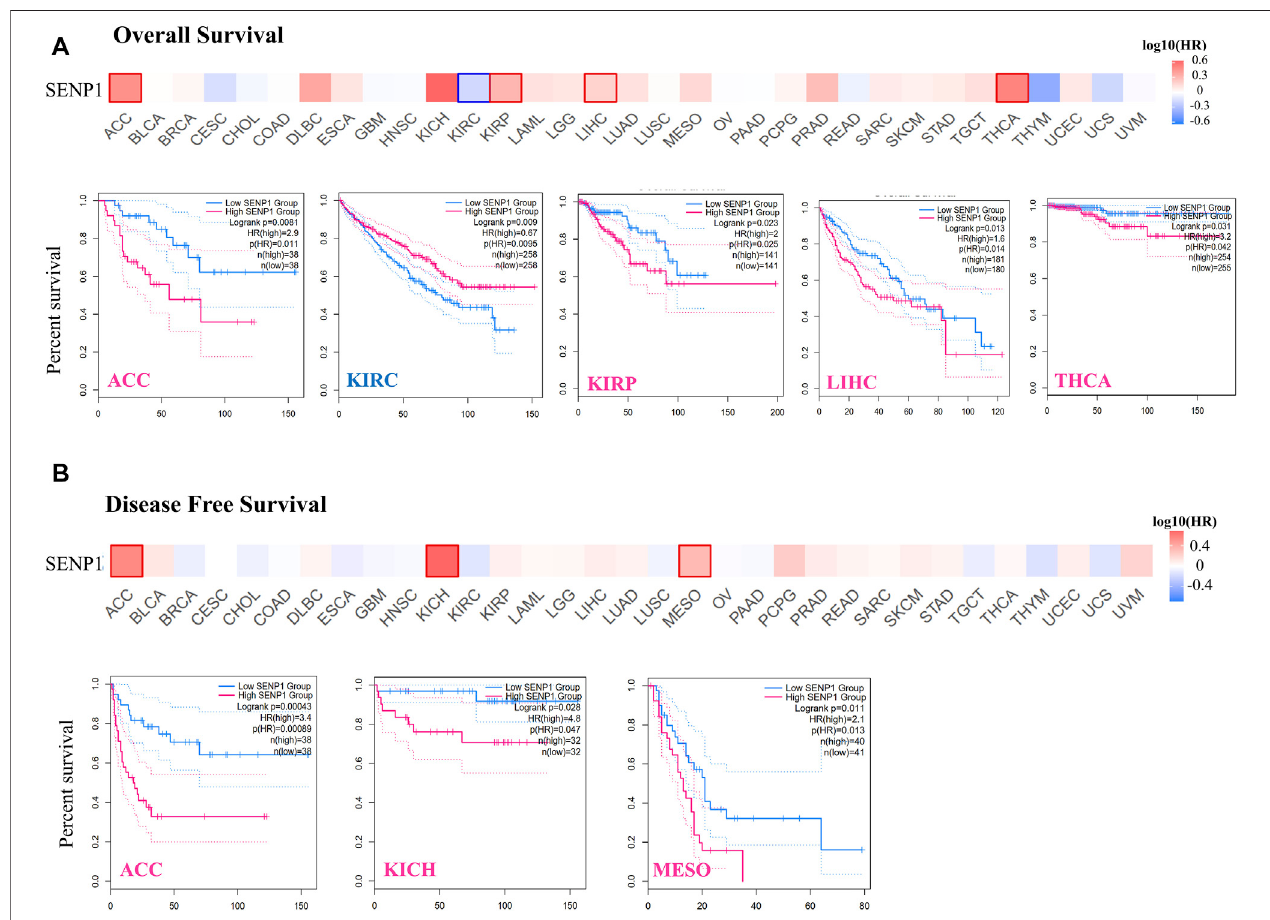
FIGURE 5 | Survival of patients with the altered SENP1 expression in various tumors, (A) Overall survival of SENP1 in ACC, KIRC, KIRP, LIHC, and THCA, and (B) Disease-Free Survival of SENP1 in ACC, KICH, and MESO.